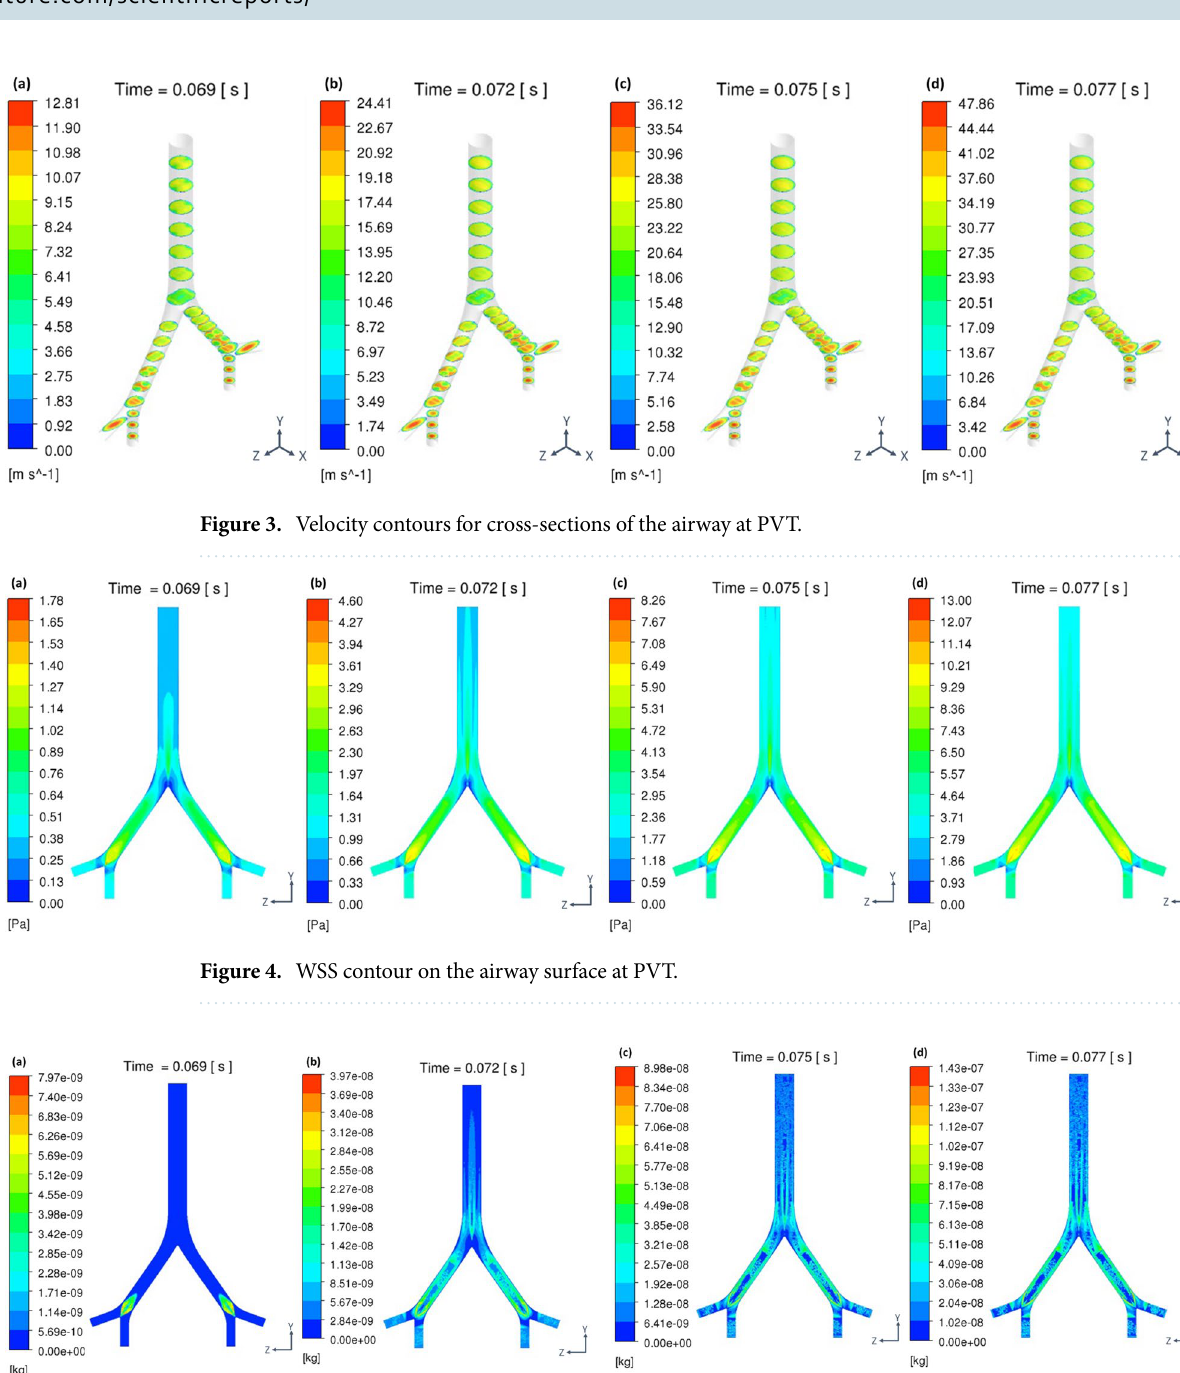
Figure 5. Stripped particle mass contour on the airway surface at